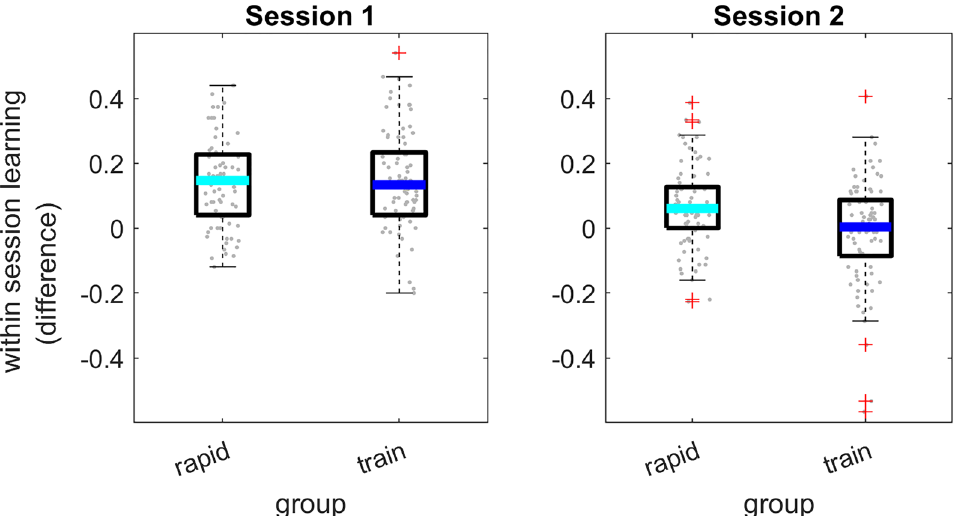
Figure 3. Rapid (within-session) learning as a function of group. Rapid learning, defined as the difference in performance accuracy between the first 5 and last 5 time-compressed sentences on each session. rapid = rapid- learning group; train = training group. Background symbols denote individual data. The thick line within each boxplot shows group median; box edges mark the interquartile range; whiskers are 1.5 times the interquartile range; + signs are values outside of the 1.5 × interquartile